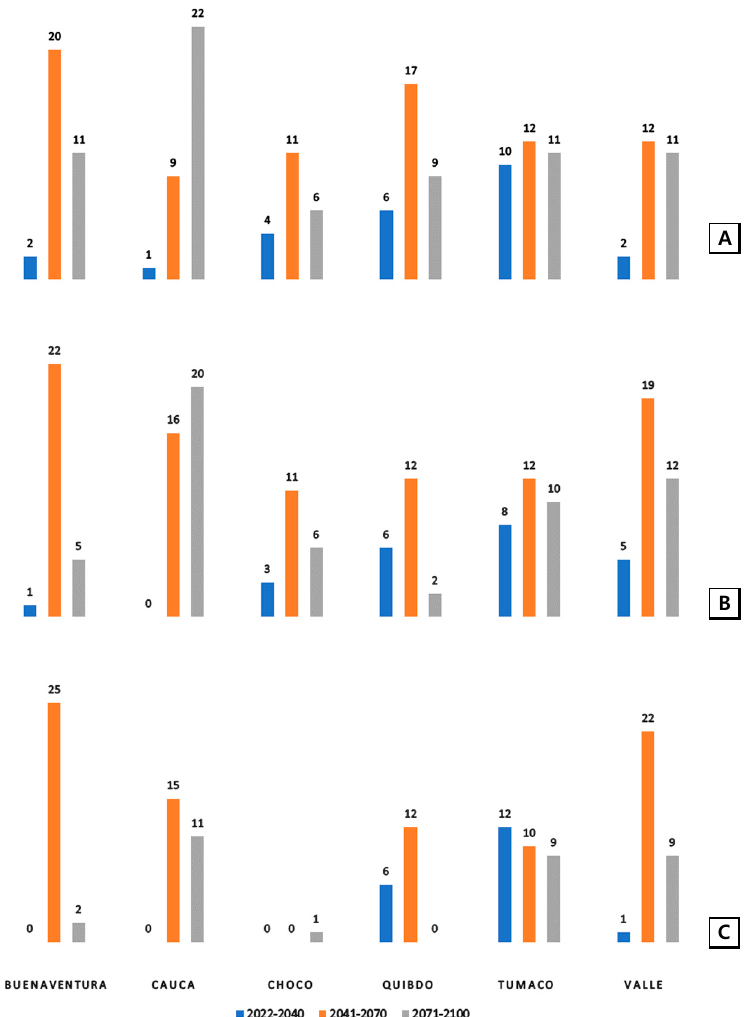
Figure 7. Number of Extremely Dry events in Colombia’s Pacific region under the RCP 4.5 scenario (2022–2100). ( A ) SPI 3; ( B ) SPI 6; and ( C ) SPI 12.